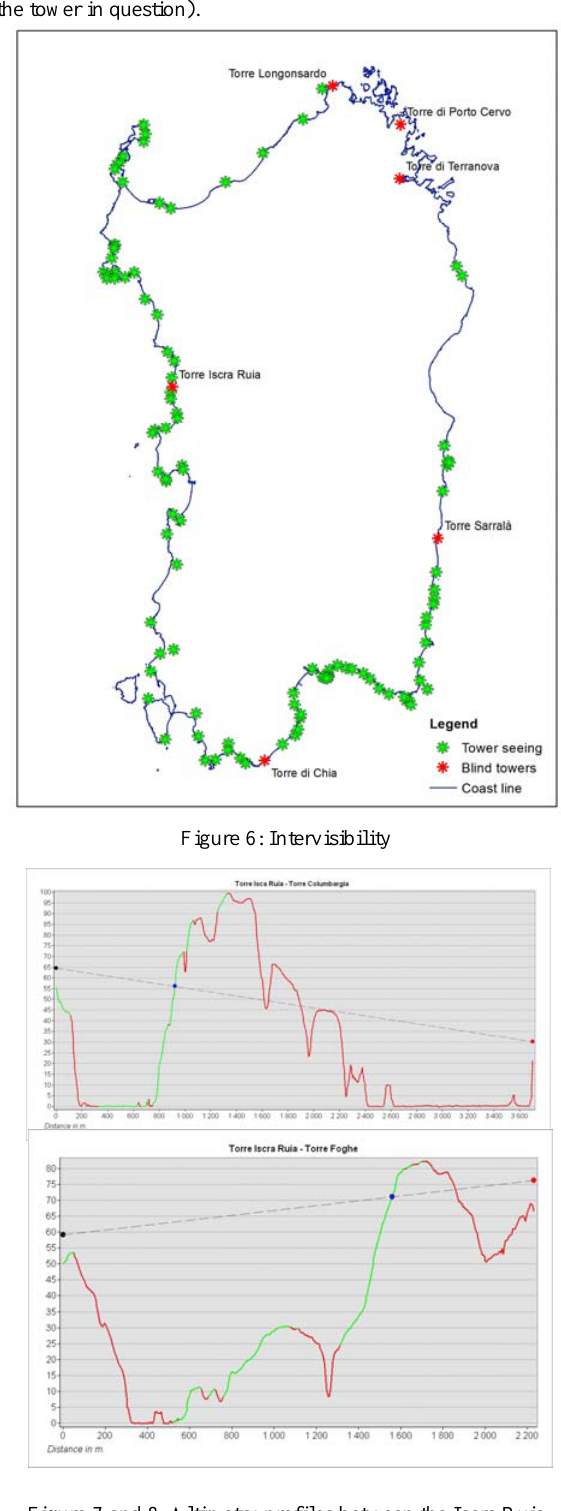
Figure 7 and 8: Altimetry profiles between the Iscra Ruia Tower respectively the previous and next the